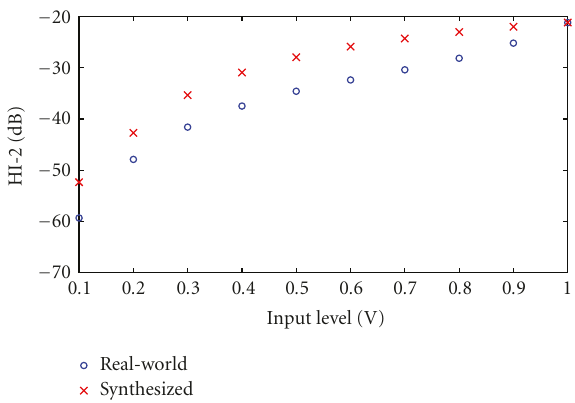
Figure 6: HI-2 of synthesized and real-world signals as a function of the input level (pedal